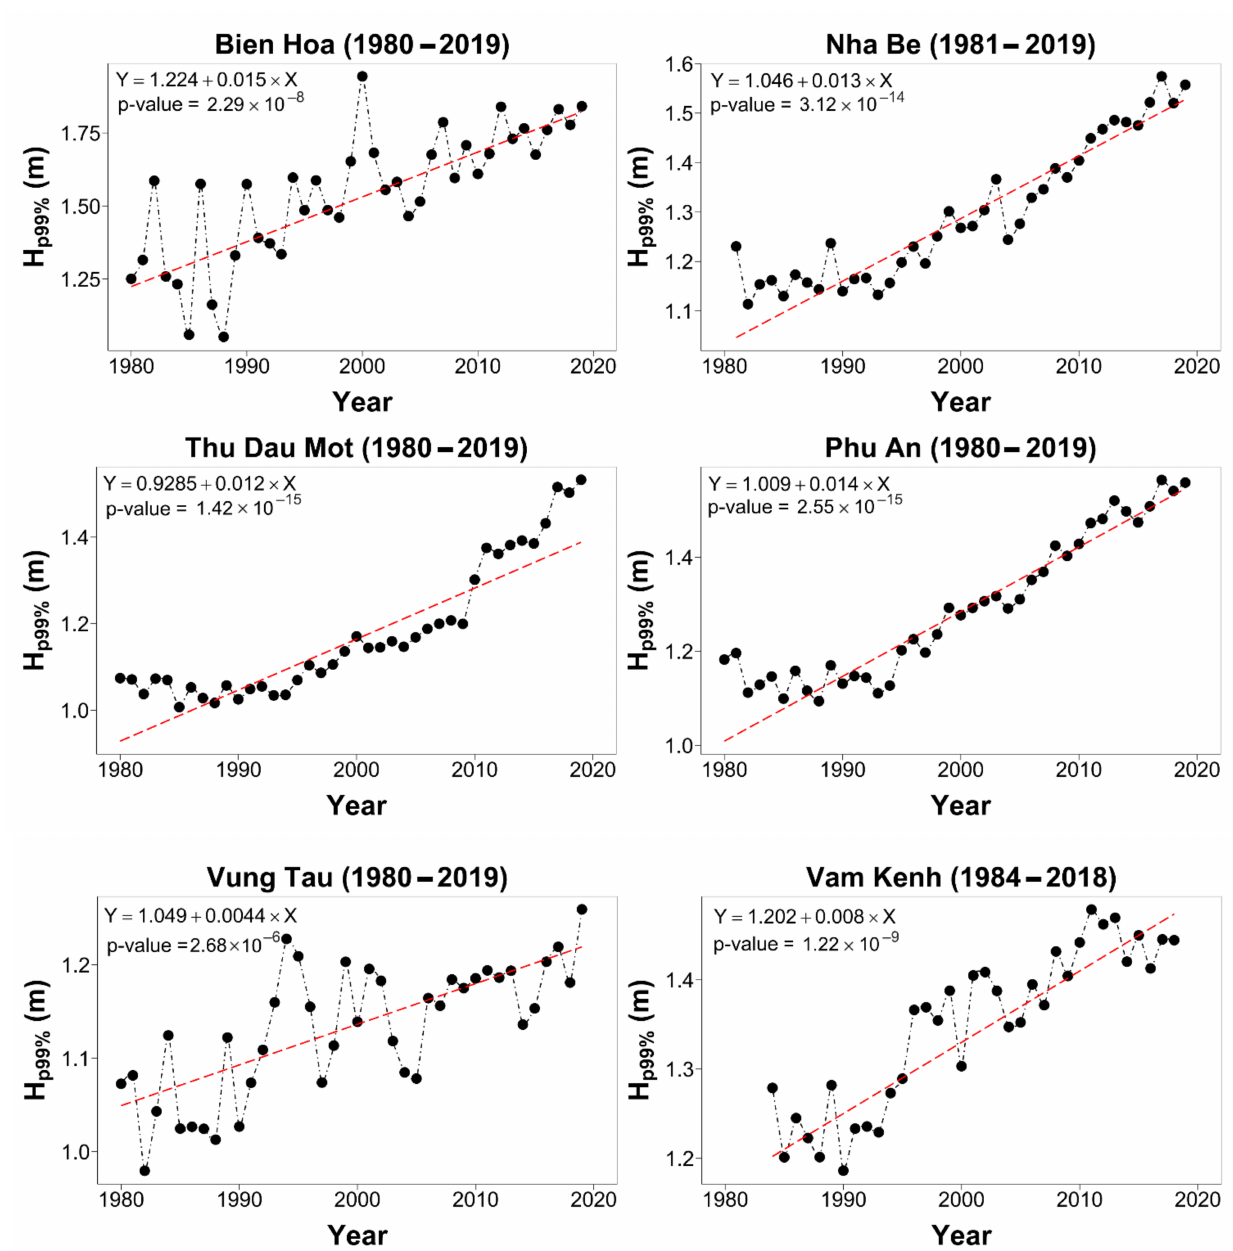
Figure A1. Water level trends H p99%